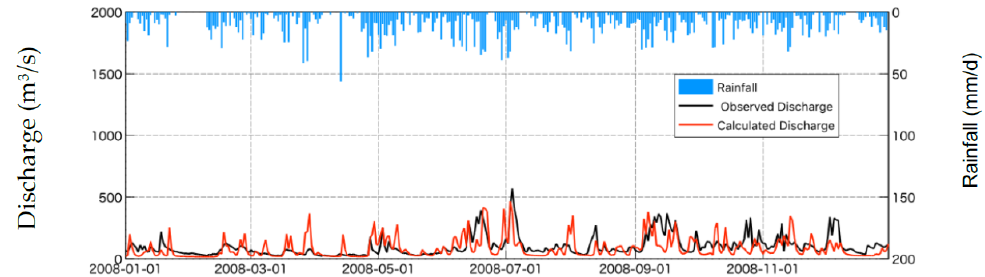
Figure 4. Validation results of river discharge at the Lacson station with CHIRPS, satellite-based rainfall.